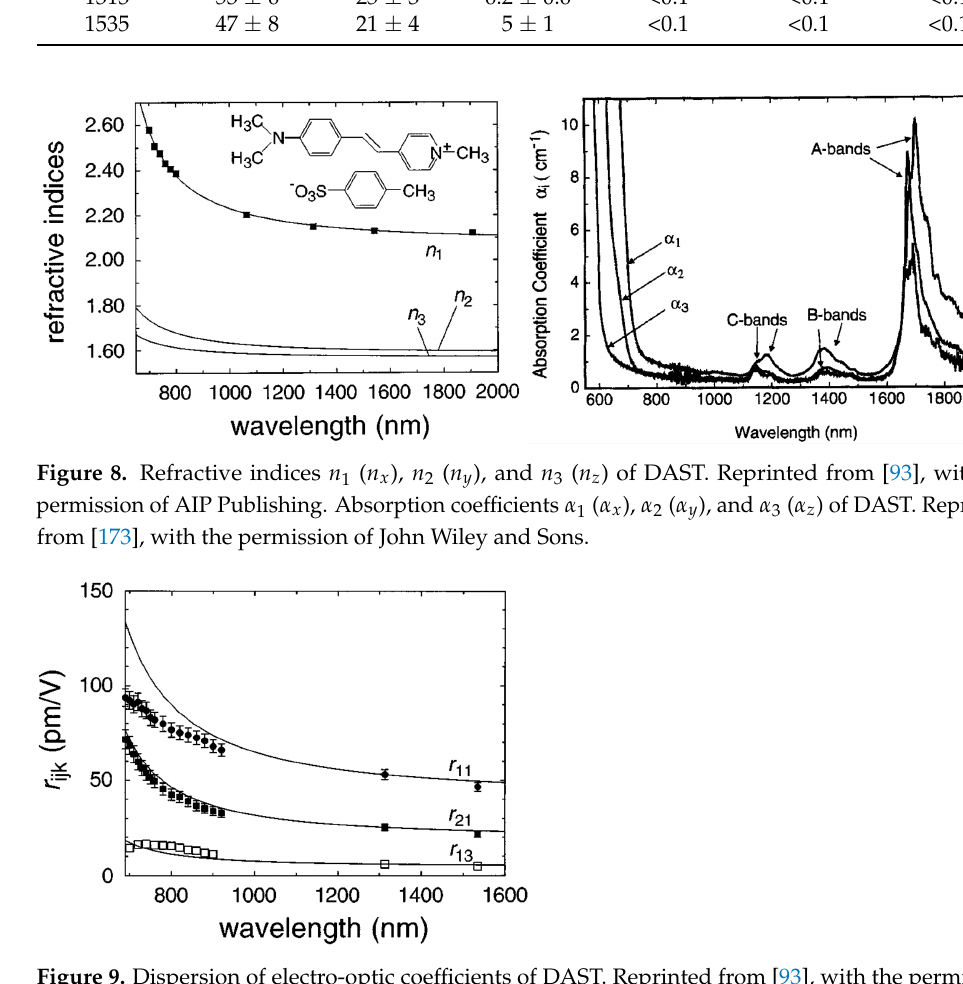
Figure 9. Dispersion of electro-optic coefficients of DAST. Reprinted from [93], with the permission of AIP